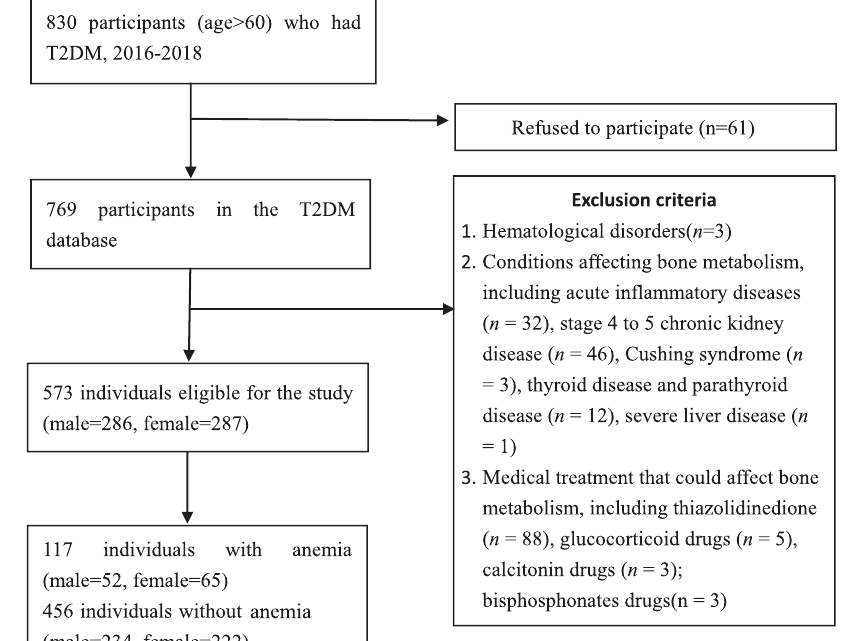
Fig. 1 Flow chart on selection of